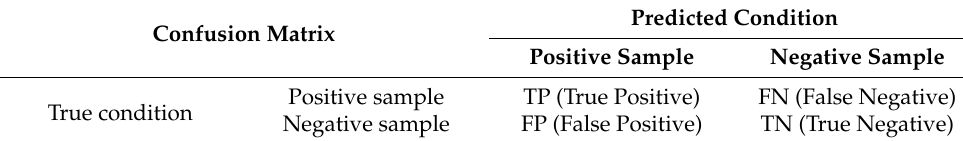
Table 2. Confusion matrix relationship